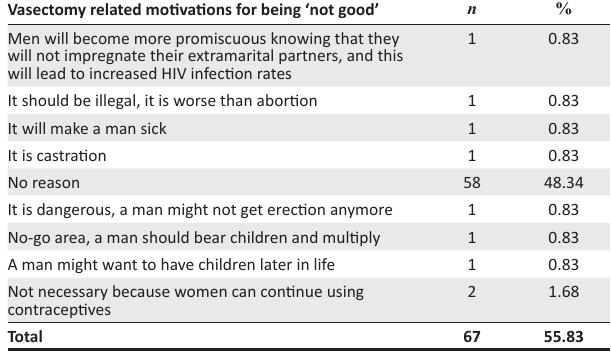
TABLE 3: Vasectomy related